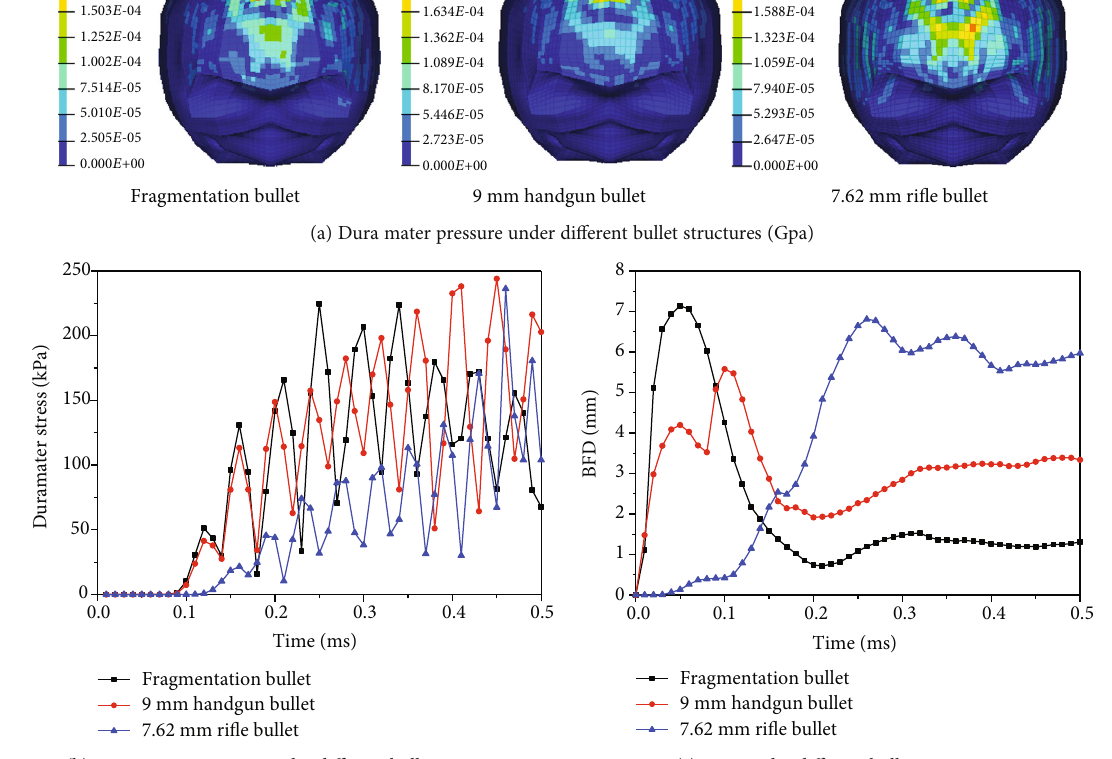
Figure 10: Brain response under di ff erent bullet